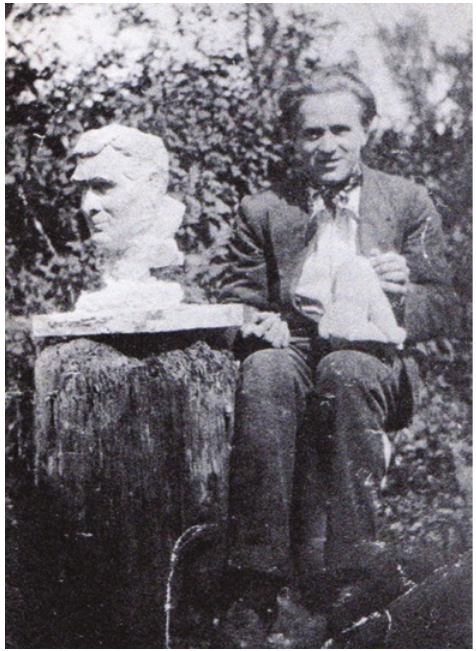
Figure 2. Tommy at Chaldon with his bust of Theodore Powys (Source: By permission of M.A.B.